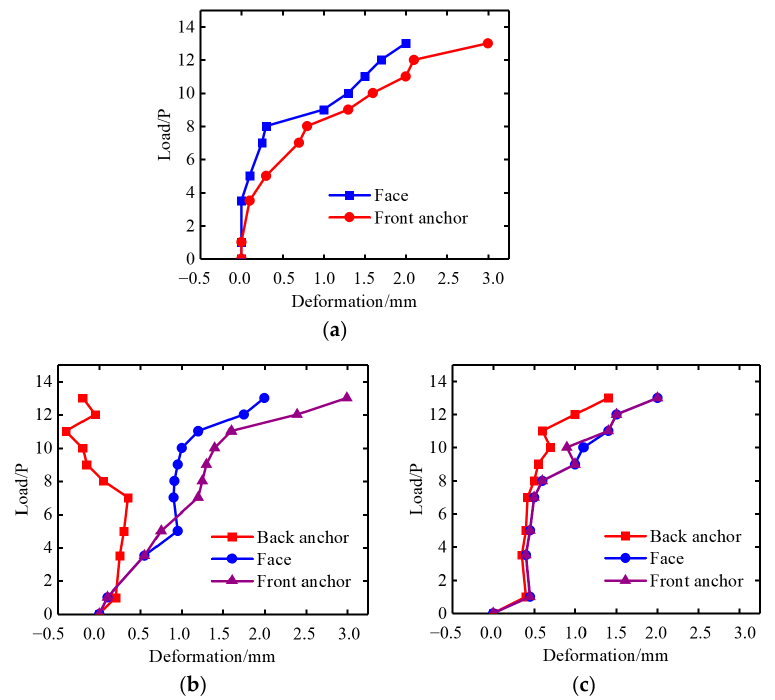
Figure 18. Test results of surrounding rock deformation outside anchor tunnel: ( a ) Middle pier; ( b ) Outside of left anchor hole (H1); ( c ) Top of left anchor hole (H2).